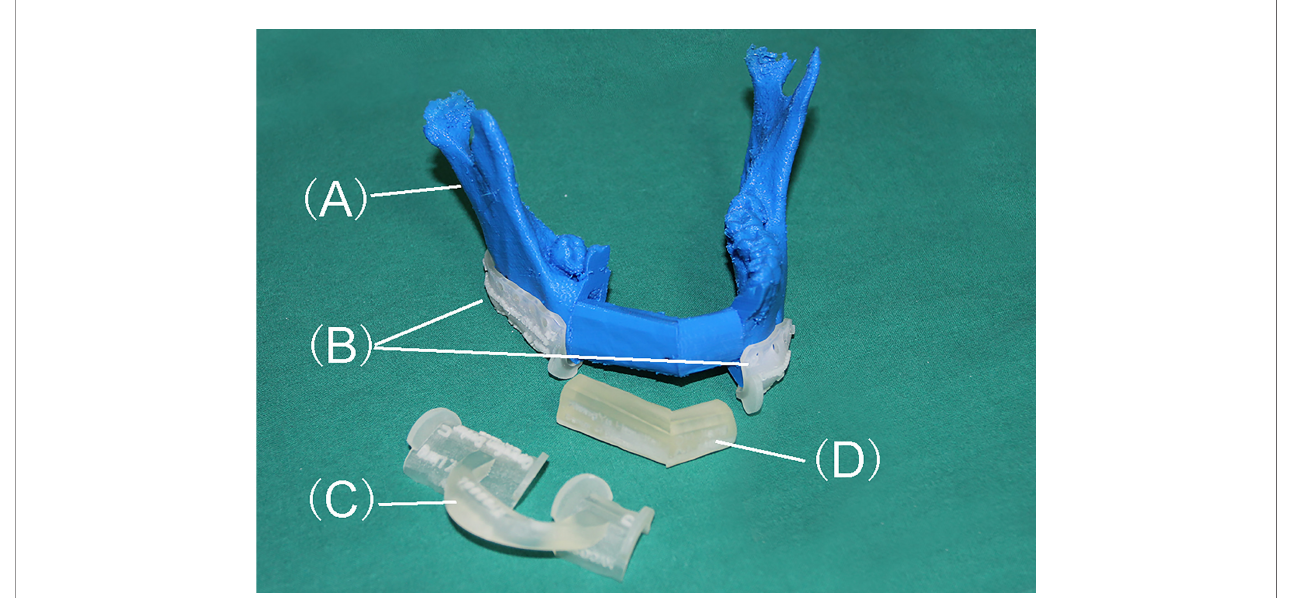
FIGURE 4 | 3D printout templates of models and CORPPP guiding templates. (A) Expected mandible model after reconstruction. (B) CORPPP mandibulectomy guiding templates with fi xing holes. (C) CORPPP fi bular osteotomy template. (D) CORPPP positioning